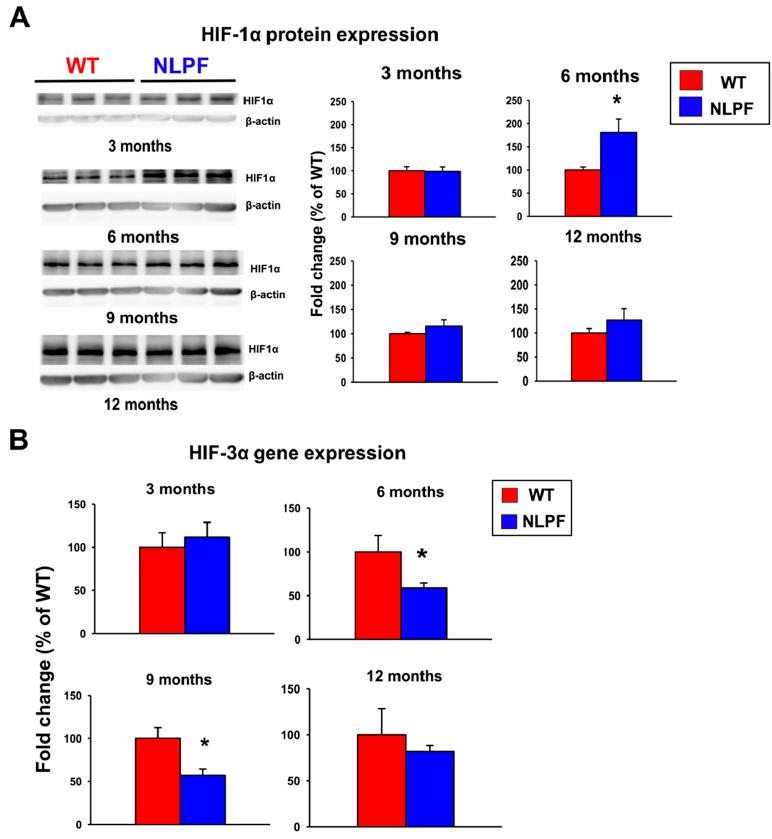
Figure 6. Relative expression of HIF in the hippocampal tissue of APP NL-P-F/NL-P-F mice from three to twelve months of age. ( A , B ) Fold change in ( A ) HIF-1 α protein and ( B ) HIF-3 α mRNA gene expression levels. ( A ) WT and NLPF ( n = 4). ( B ) WT ( n = 5–6), NLPF ( n = 6). Values indicate the mean ± SEM. * p < 0.05 compared with age-matched WT.